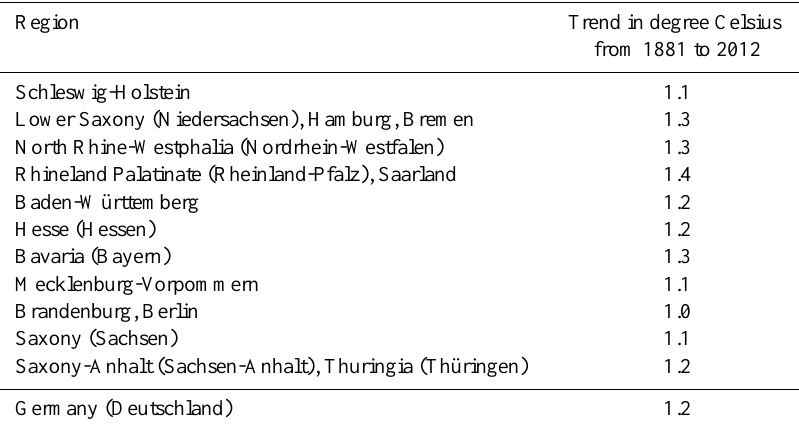
Table 4. Trend of the annual mean temperature in Germany’s federal states from 1881 to 2012 (i.e. change in areal mean temperature). For small states values are